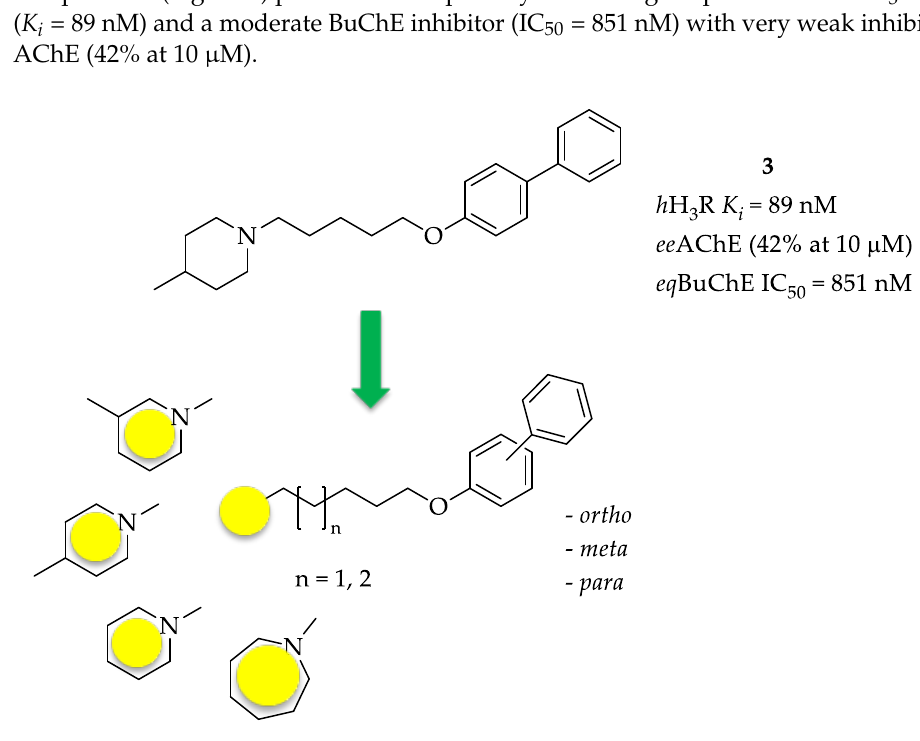
Figure 3. Structures of investigated compounds.